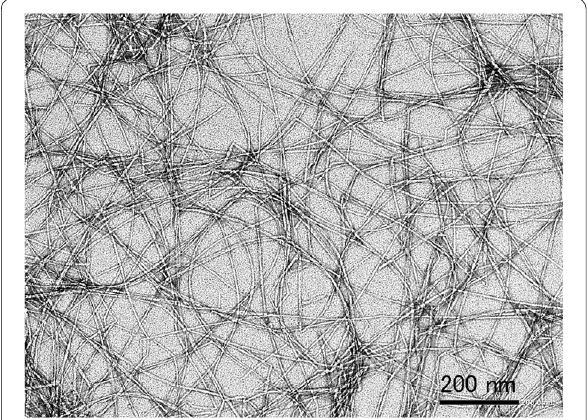
Fig. 8 Transmission electron microscopy image for TEMPO-oxidized cellulose microfibrils prepared from the colorless